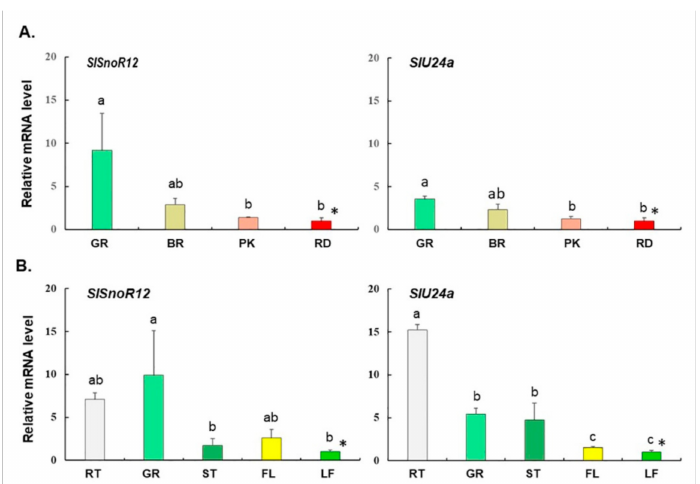
Figure 1. Quantitative RT-PCR of tomato fruit at di ff erent ripening stages ( A ) and of vegetative tissues ( + green fruit) ( B ). The values were normalized to the lowest value of either fruit ripening stage or the tissue type indicated by asterisks. ( A ) The fruit ripening stages, i.e., mature green (GR), breaker (BR), pink (PK), and red (RD). ( B ) Di ff erent tissue types, i.e., root (RT), mature green fruit (GR), stem (ST), flower (FL), and leaf (LF). The bars represent standard errors of mean (N = 3). The di ff erent letters above bars indicate statistical significance at p ≤ 0.05 as determined by Tukey’s test. * Represents the tissue used for normalization.